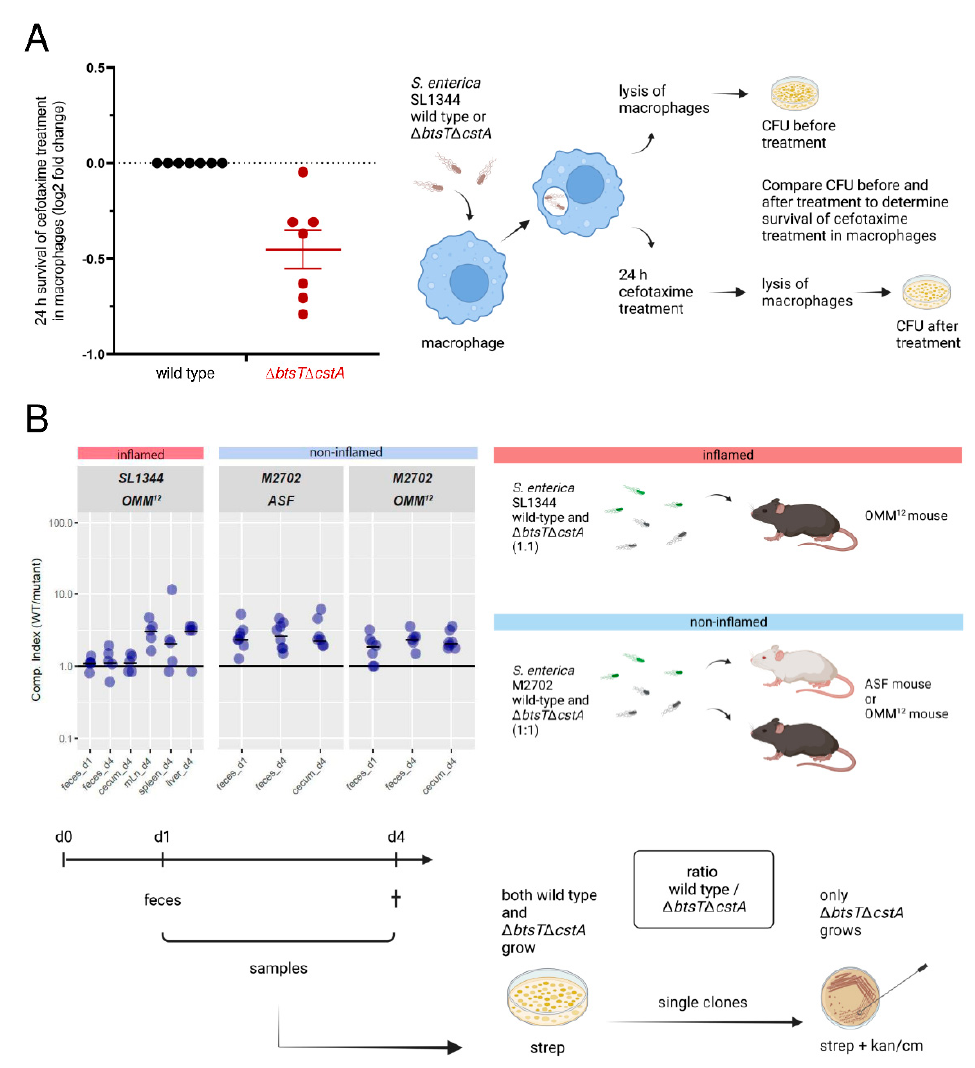
Figure 5. In vivo phenotypes of S . Typhimurium ∆ btsT ∆ cstA mutant. ( A ) Intra-macrophage antibiotic survival assay with schematic illustration: Bone marrow-derived macrophages were infected with either SL1344 wild-type (black) or ∆ btsT ∆ cstA (red) stationary-phase bacteria. After 30 min, one part of the macrophages was lysed, and the recovered bacteria were plated to determine CFUs. The other part of infected macrophages was treated with cefotaxime and incubated for 24 h, followed by macrophage lysis and plating to determine CFUs. The number of CFU after antibiotic treatment was set in relation to the number of CFU prior to antibiotic treatment. The 24 h antibiotic survival was then expressed as a fold-change of wild-type values. Using the paired student t-test on the 7 biological repeats a p -value of 2.83 × 10 − 6 was determined. ( B ) Competition assay in gnotobiotic mice with schematic illustration: OMM 12 or ASF mice were inoculated with both wild-type and ∆ btsT ∆ cstA cells (ratio 1:1) of the virulent strain SL1344 or the avirulent strain M2702, respectively. One day after infection, fecal samples were collected and plated on MacConkey agar with streptomycin, which selects for all S. enterica cells owing to natural resistance. Four days after infection, all mice were sacrificed and samples from feces, cecum, lymph nodes, spleen, and liver were plated on MacConkey agar with streptomycin. Single colonies were streaked on MacConkey agar with streptomycin plus kanamycin (for SL1344) or chloramphenicol (for M2702) to select for Δ btsT Δ cstA cells. By this means, the competitive index could be determined, i.e., the ratio between wild-type and Δ btsT Δ cstA cells. All illustrations were created with BioRender.